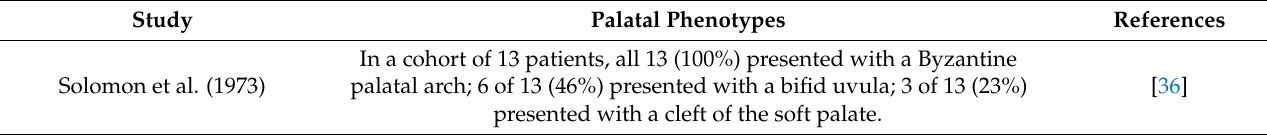
Table 1. Palatal phenotypes in cohort studies of Apert